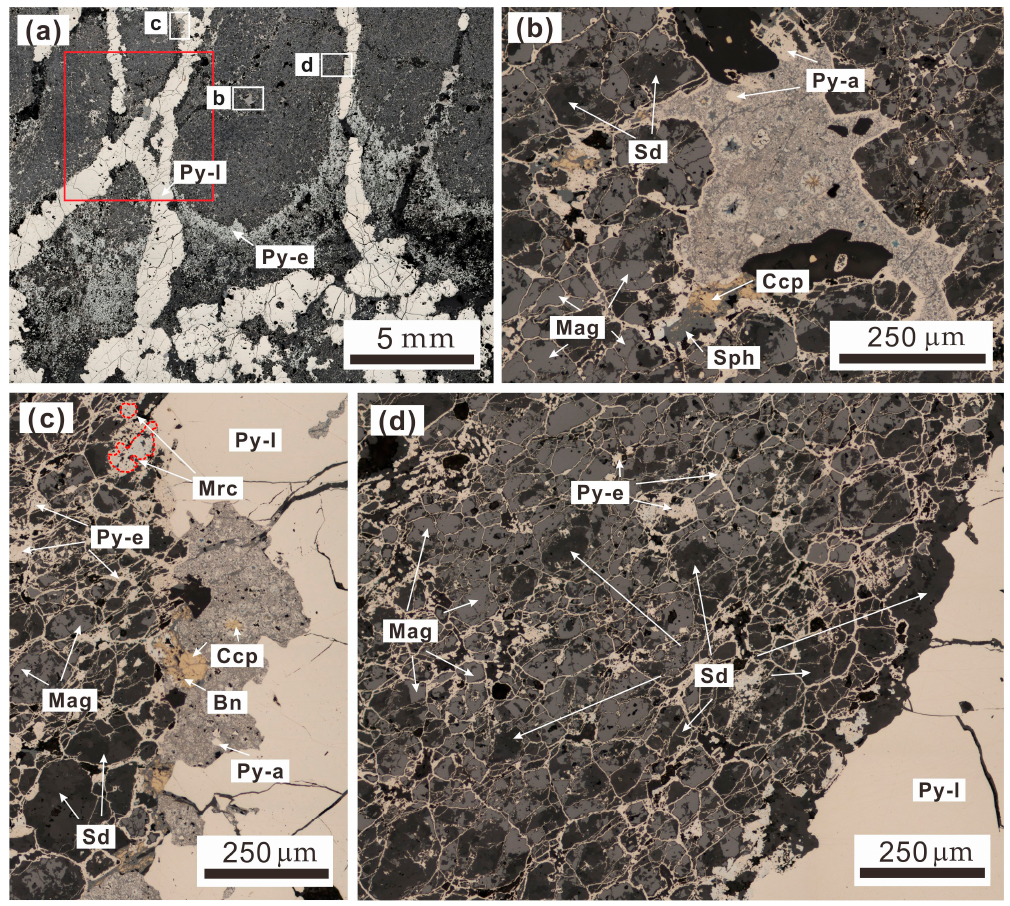
Figure 1. Photomicrographs in reflected light showing petrographic aspects of the studied sample. ( a ) Overview of the hand specimen, the early stage pyrite (Py-e) is associated with siderite-magnetite-dominant matrix that was crosscut by late-stage pyrite veins (Py-l); ( b ) the main-ore stage with multi-component sulfide assemblage including chalcopyrite (Ccp), sphalerite (Sph), Bornite (Bn) and pyrite (Py-a); ( c ) early pyrite (Py-e) hosted interstitially within the siderite (Sd)-magnetite (Mag) matrix and has possibly replaced marcasite (Mrc); relict marcasite can be seen within Py-e; ( d ) replacements of siderite by magnetite within the sample matrix.